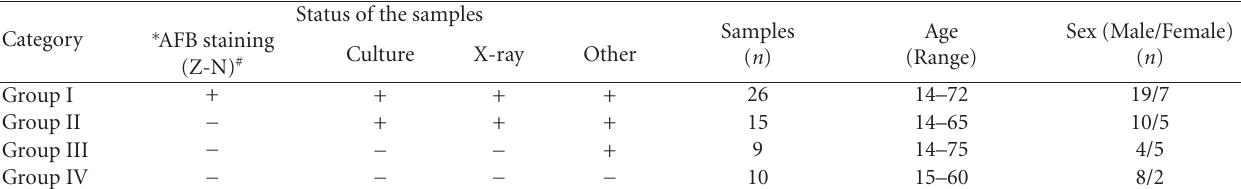
Table 1: Characteristics of clinical samples and controls based on conventional diagnostic methods and other clinical symptoms.